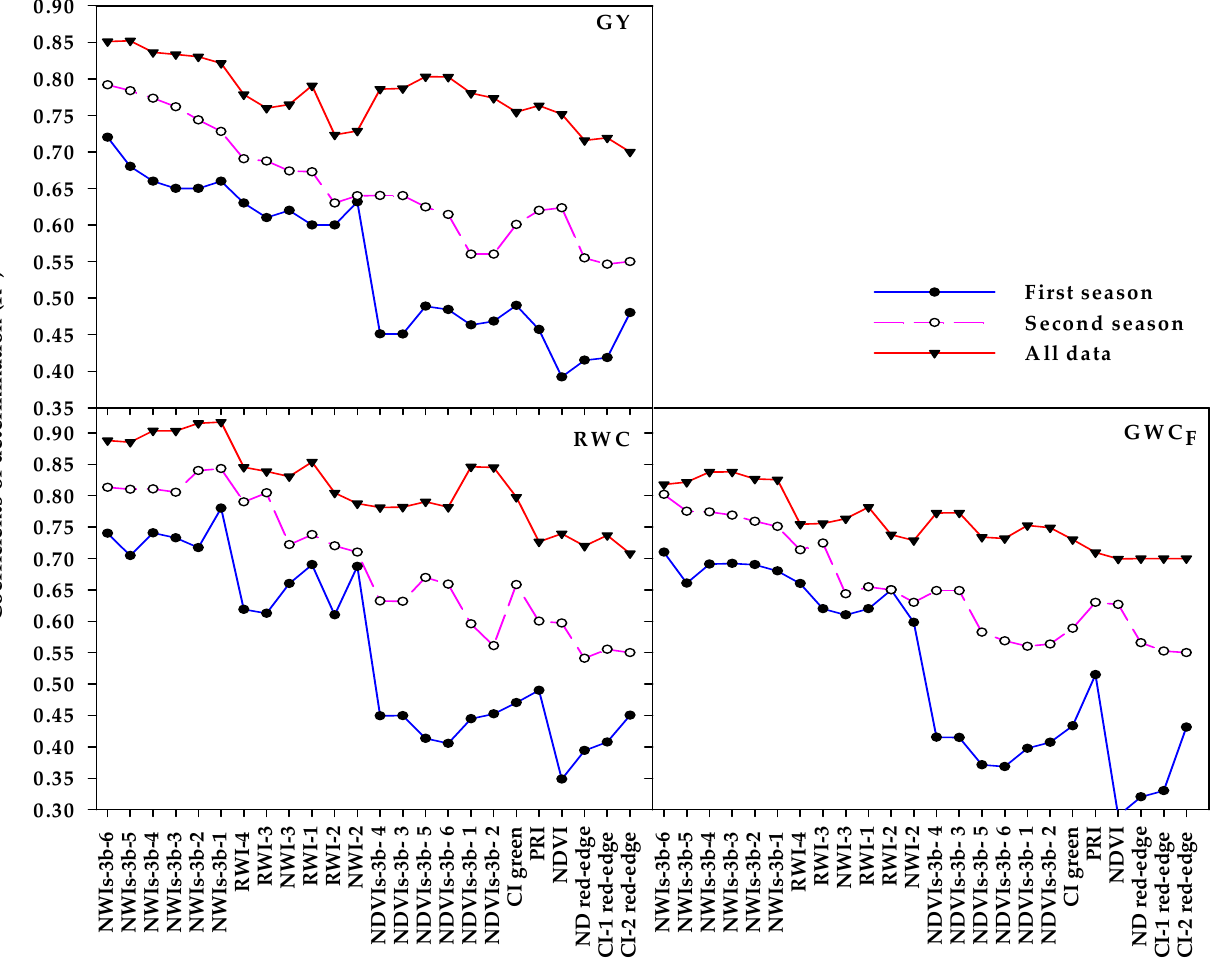
Figure 6. Coefficients of determination (R 2 ) for the relationship between the different spectral reflectance indices (SRIs) and the relative leaf water content (RWC), gravimetric water content on a fresh weight basis (GWCF), and the grain yield (GY), for each season and across all data. The full names of the different SRIs are listed in Table 2.